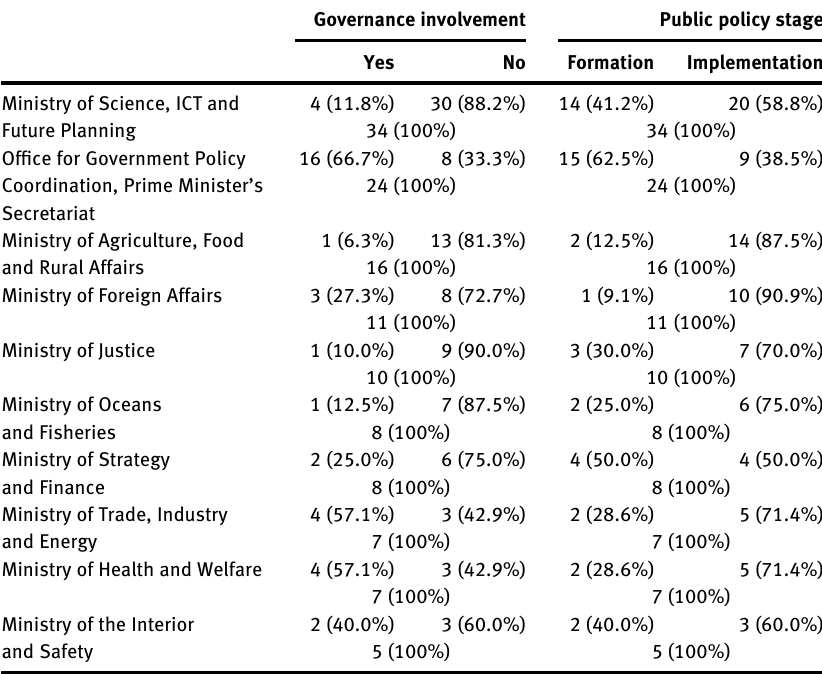
Table  : Civil society involvement & public policy process: Top  government